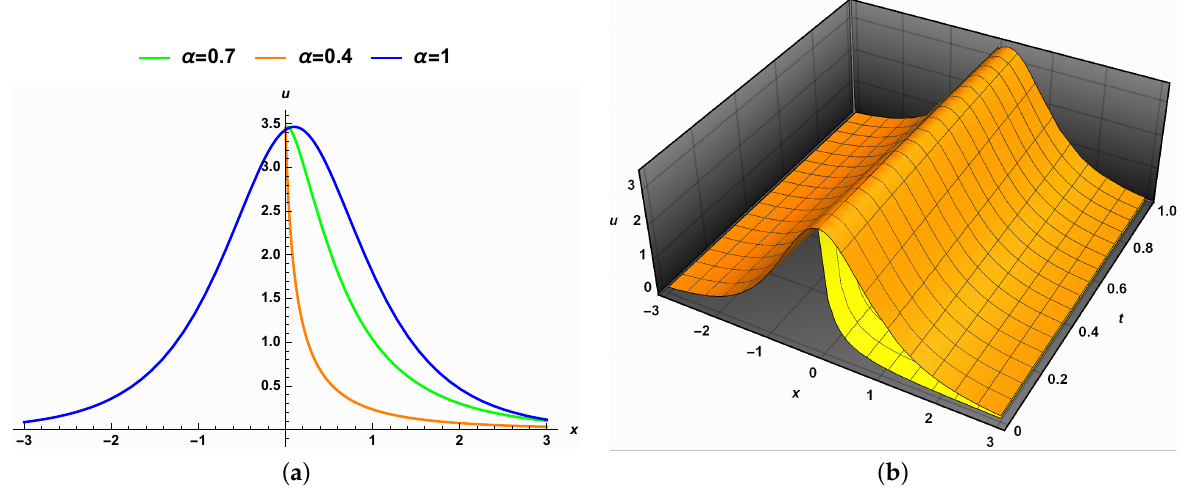
Figure 7. The effect of the fractional order α on the solution (27) when σ = 0.